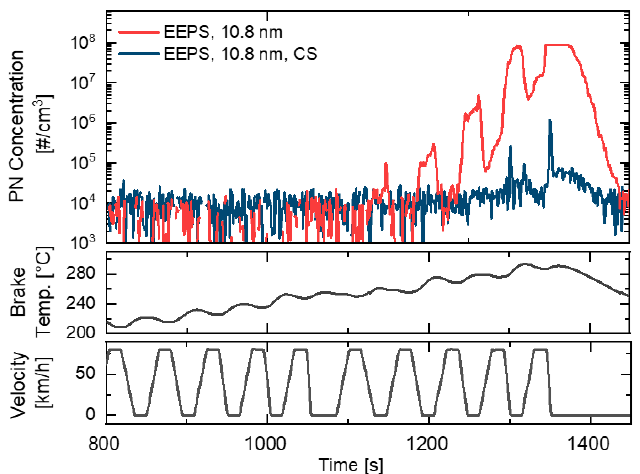
Figure A4. Particles on the 10.8 nm channel of the EEPS during continuous braking and at high brake temperatures. EEPS measurements of the total particle concentration are shown in red, and those in blue were with a catalytic stripper placed upstream. The particle concentration was corrected for losses in the CS.